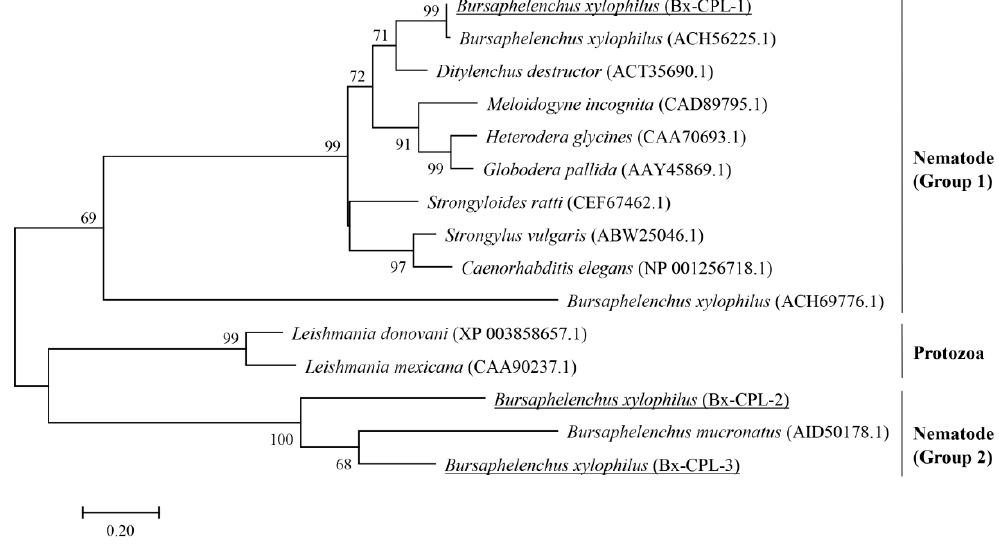
Figure 2. Phylogenetic relationships of cathepsin L-like cysteine proteinases (CPLs). The phylogram was constructed based on amino acid sequences to determine the evolutionary relationships among 15 CPL proteins from different species using MEGA 7. The numbers below the branches indicate the bootstrap values, which were calculated from 1000 replicates. The GenBank accession numbers of the sequences are in brackets. B. xylophilus CPLs (Bx-CPL-1, Bx-CPL-2 and Bx-CPL-3) are underlined. Distance scale = 0.2.